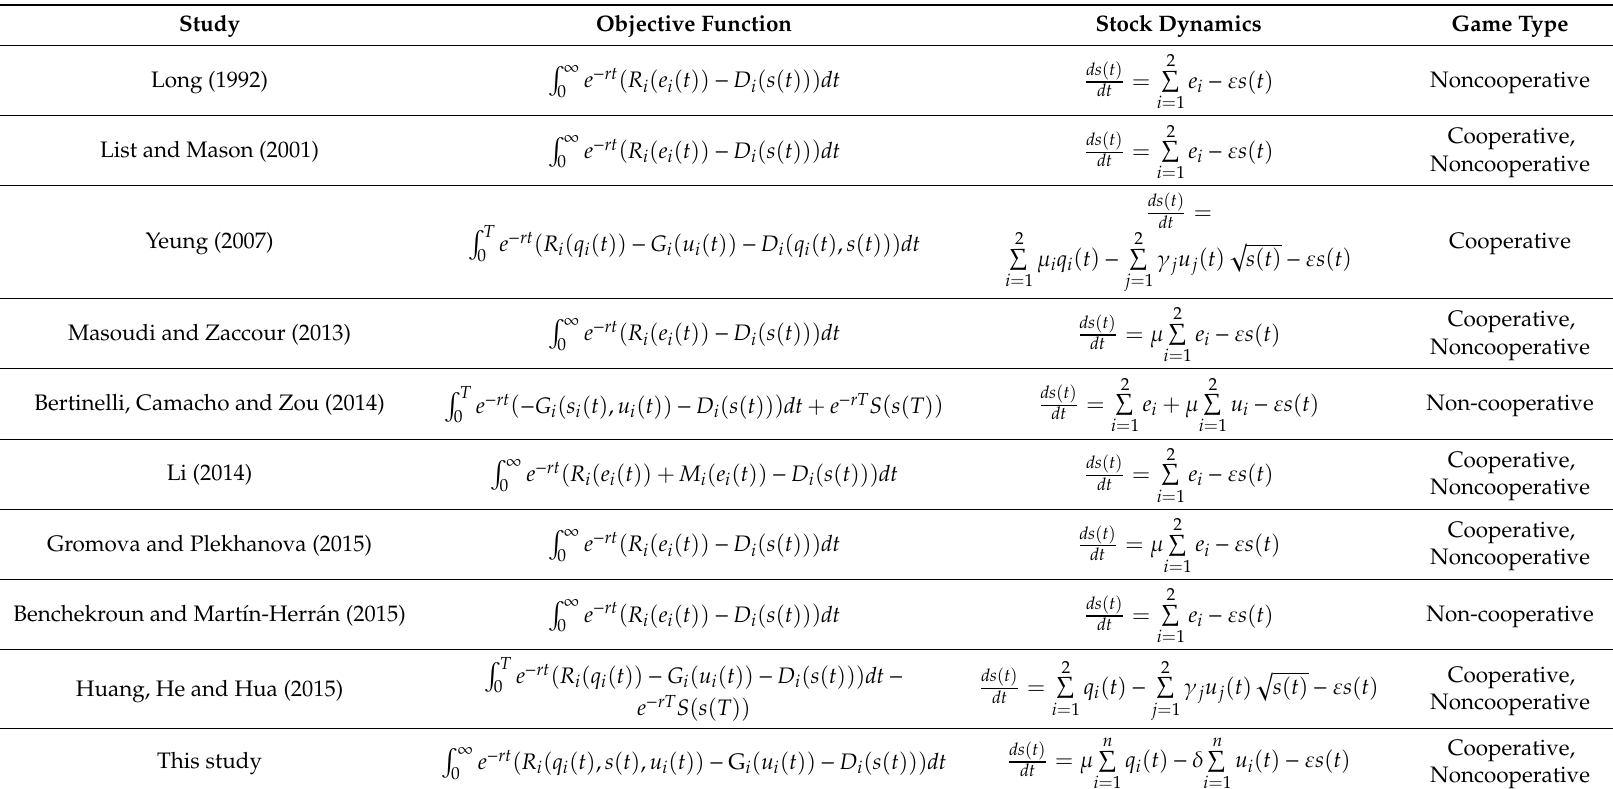
Table 1. Some game models of transboundary emissions of CO 2 /